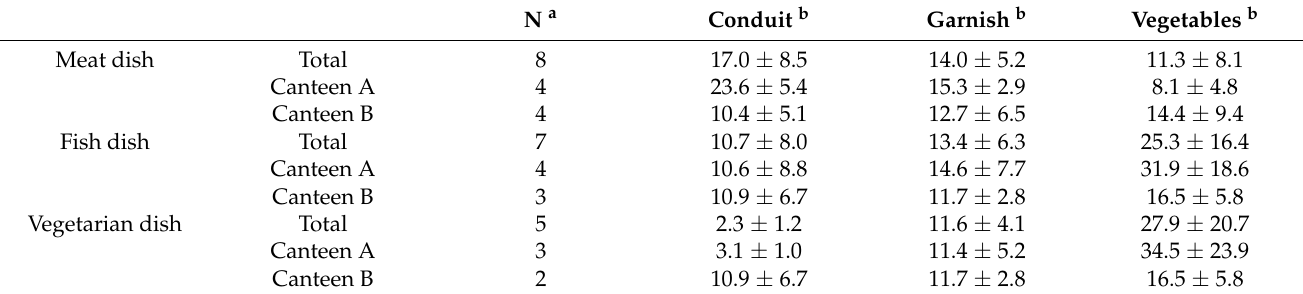
Table 3. Food waste (%) characterization in canteens (A and B) from public